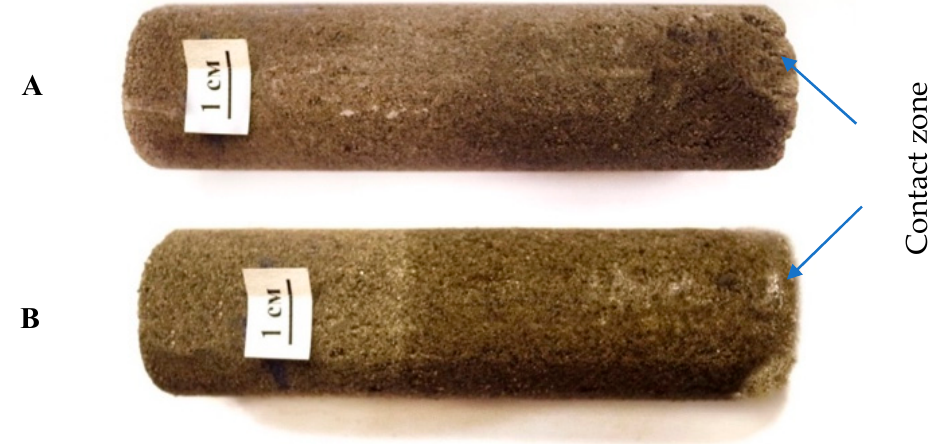
Figure 5. Frozen sandy samples (sand 2, W = 15%) before ( A ) and after interaction ( B ) with 0.2 N NaCl solution at − 3 °C.